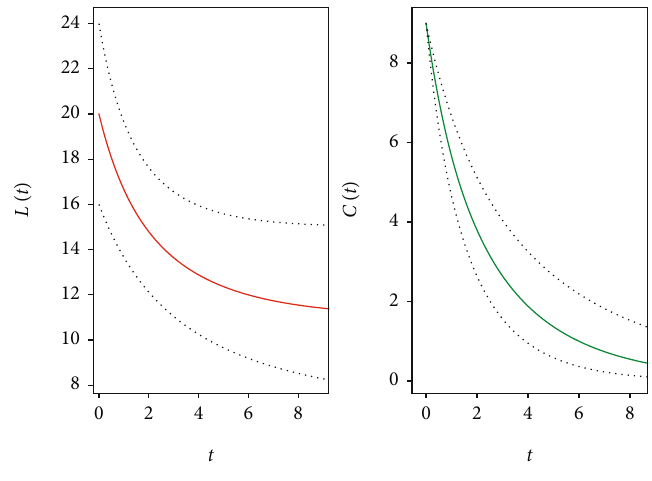
Figure 5: Functions L ð t Þ and C ð t Þ , α = 20 % . Table 6: The main points of quality control of surface waters in the Ili River basin.